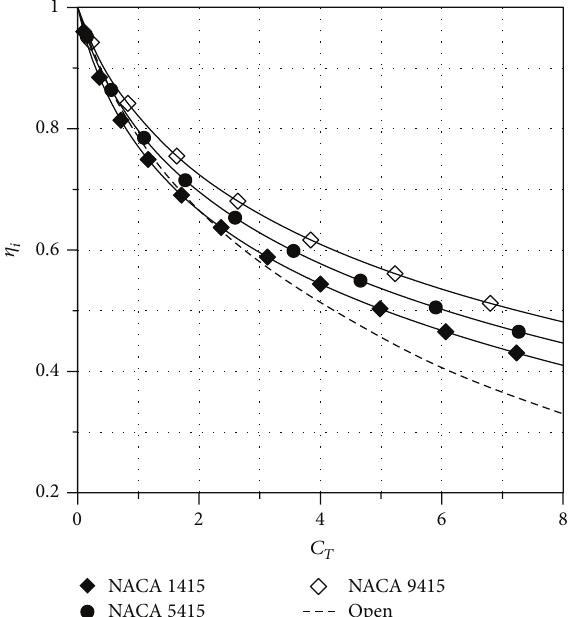
Figure 10: Effects of the profile camber on the propulsive